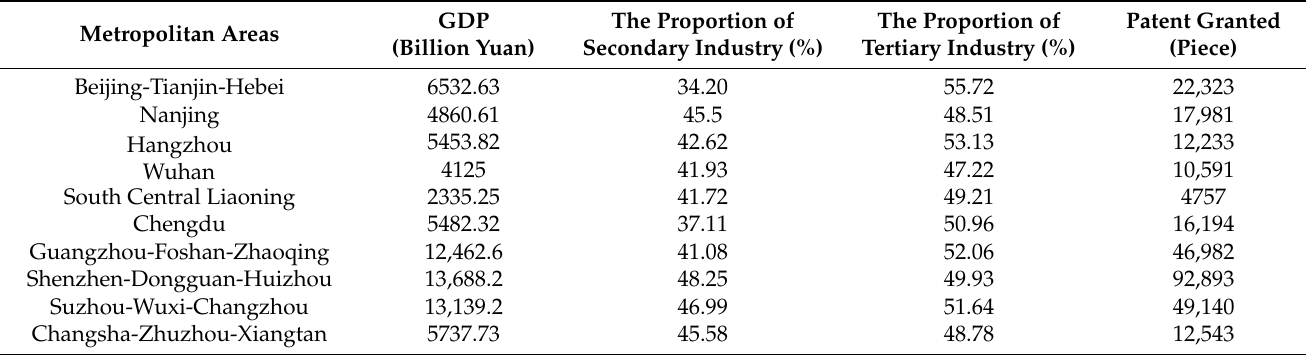
Table 6. The average annual economic growth of ten metropolitan areas in